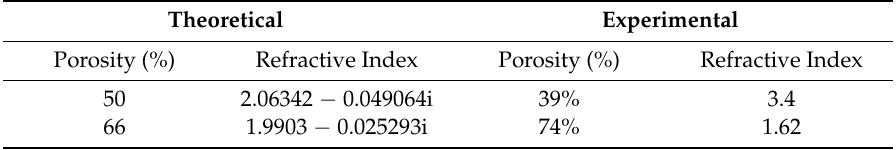
Table 1. Experimental and theoretical comparison of porosity values for two different dielectric layers.